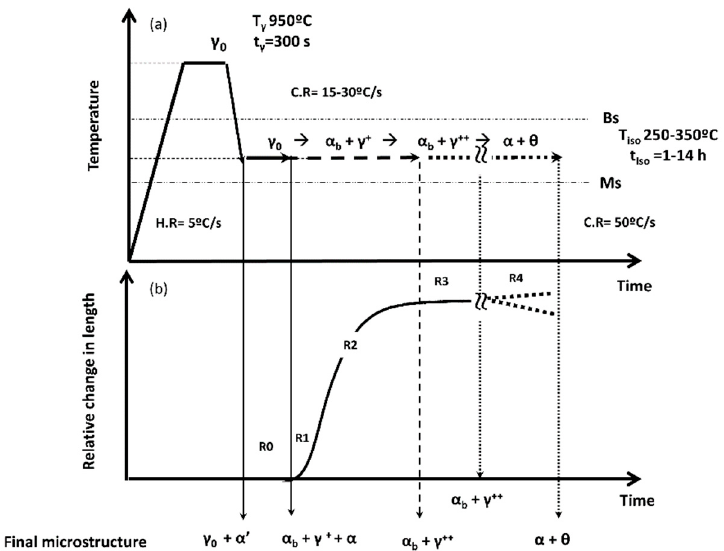
Figure 1. ( a ) Scheme of the performed heat treatment, where H.R and C.R stand for heating and cooling rate, respectively, Bs and Ms for the bainite and martensite start temperatures, respectively, and α , γ , and θ for ferrite, austenite, and cementite, respectively. ( b ) Exemplified dilatometric signal, where the di ff erent stages and microstructures that can be obtained depending on the holding time can be seen. The regions delimited by R correspond to the four di ff erent regions that have been described in the main body of the text.